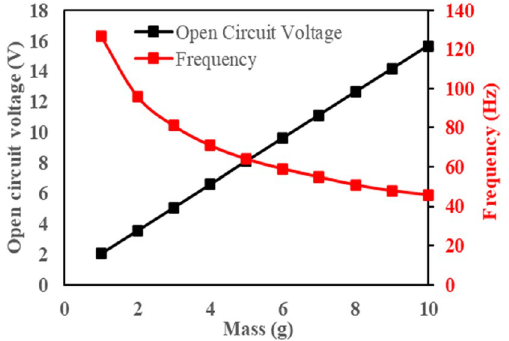
Figure 3. Effect of mass on natural frequency and open-circuit voltage of piezoelectric beam (computation